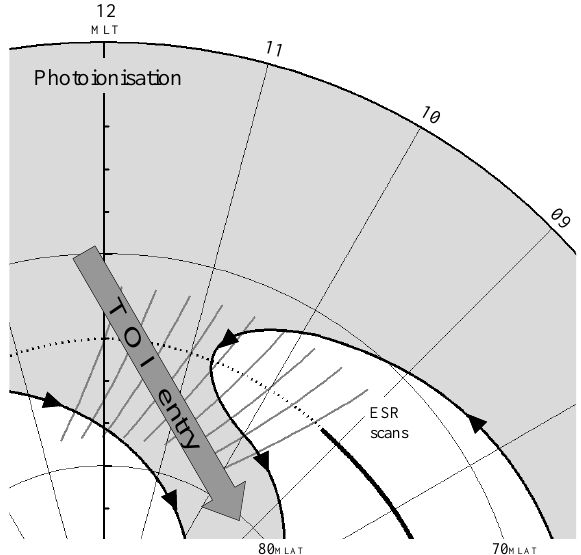
Fig. 8. Summary schematic showing the main observed features on a MLAT versus MLT polar grid during the B y > 0 and B z < 0 conditions near the end of the time interval. Superimposed are con- vection streamlines with the large grey arrow indicating the entry of the TOI, flanked by depletions in electron density on its pre- and post-noon